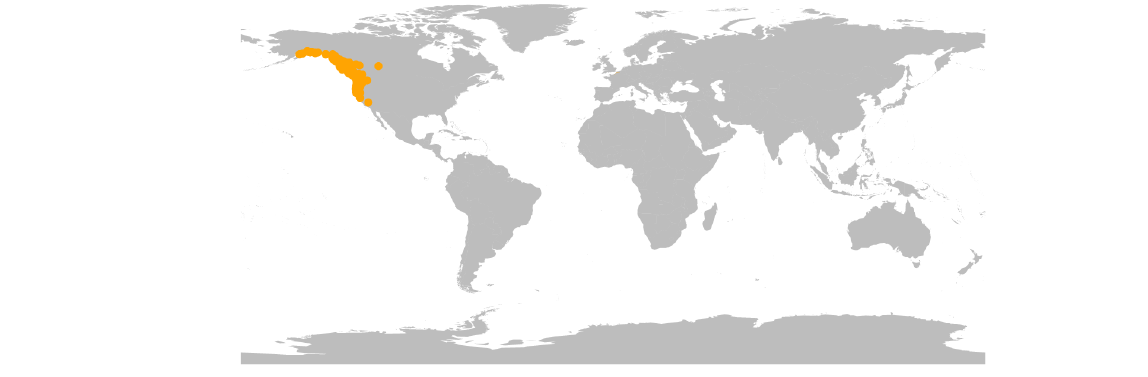
Fig. 19. Distribution of Malus fusca (Raf.)